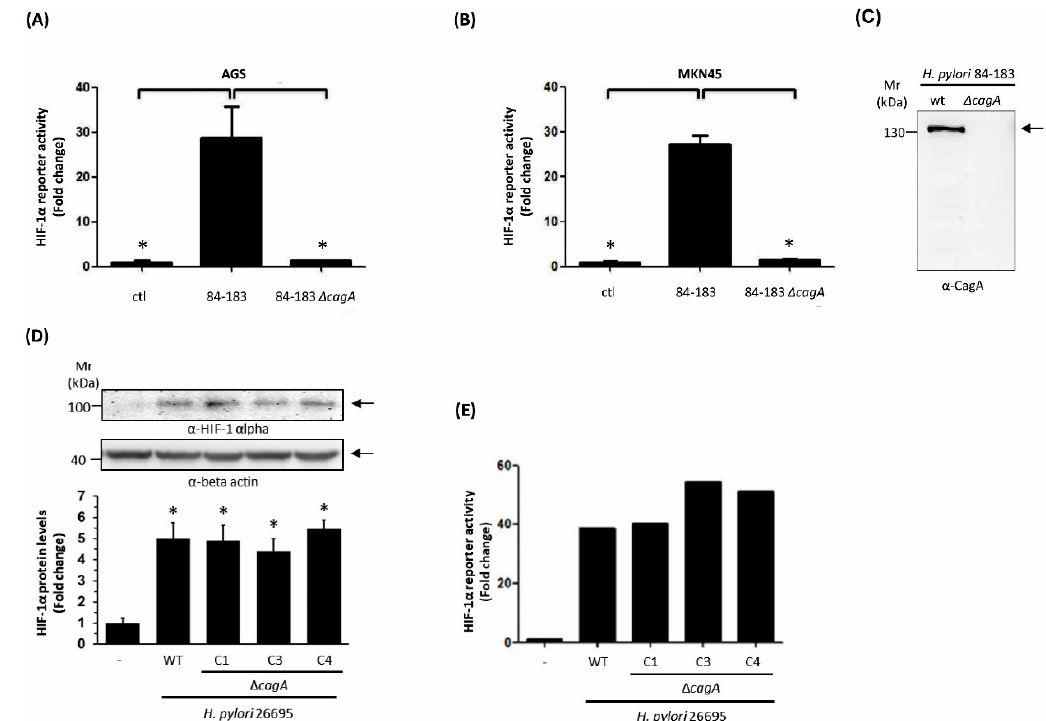
Figure 1. Hypoxia-induced factor (HIF-1) induction in response to H. pylori strains in gastric epithelial cells. AGS ( A ) and MKN45 ( B ) cells were transfected with the reporter plasmid pGL3-HRE (HIF reporter) and the control plasmid pON (beta-galactosidase). After 16 h, cells were infected with the H. pylori wild-type strain 84-183 or its isogenic Δ cagA mutant strain at a Multiplicity of Infection (MOI) 100 for 8 h. Then, protein extracts were prepared to determine luciferase reporter activity. Bars represent values of luminescence normalized to β -galactosidase activity compared with the control condition (mean ± SEM, n = 3, * p ≤ 0.05). ( C ) Immunodetection of CagA in protein extracts from H. pylori parental 84-183 and Δ cagA mutant strains. AGS cells were infected with H. pylori 26695 and three different Δ cagA isogenic clones (C1, C3, and C4) at MOI 100 for 8 h. ( D ) HIF-1 α protein and β -actin levels were analyzed by Western blotting. A representative blot is shown (mean ± SEM, n = 3, * p ≤ 0.05). ( E ) HIF-1 activation was determined by the firefly luciferase reporter assay. A representative result with the three clones is shown.